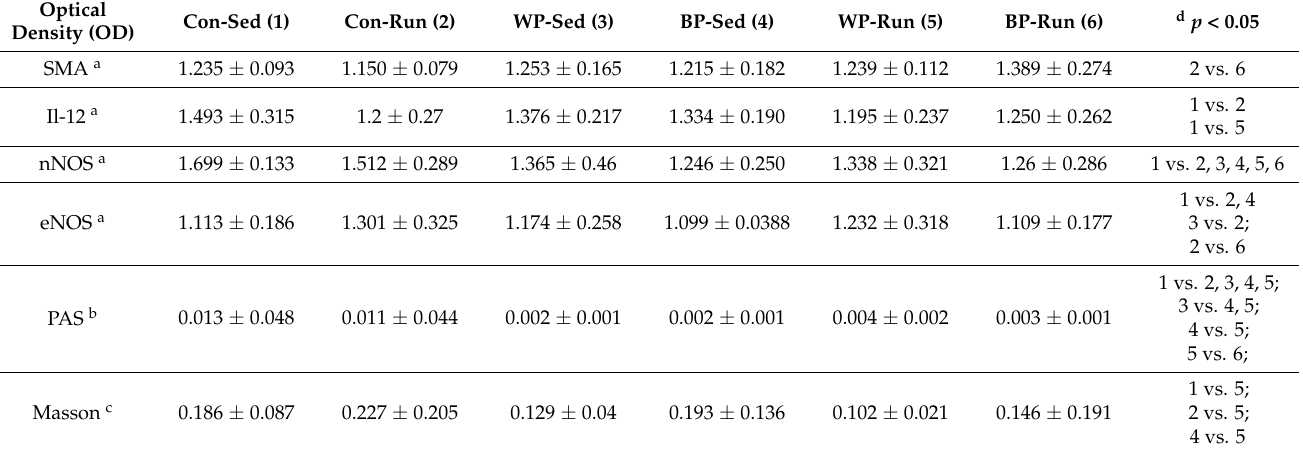
Figure 2. ( a ) Con-Sed, ( b ) Con-Run, ( c ) WP-Sed, ( d ) BP-Sed, ( e ) WP-Run and ( f ) BP-Run; Masson’s Trichrome Stain was intended for use in the histological visualization of collagenous connective tissue fibers in tissue sections; Statistical increase in collagen deposition is visible in WP-Run group compared to the Con-Run group. Table 3. The evaluation of optical density by groups in each of immunohistochemistry and Periodic Acid Schiff and Masson’s